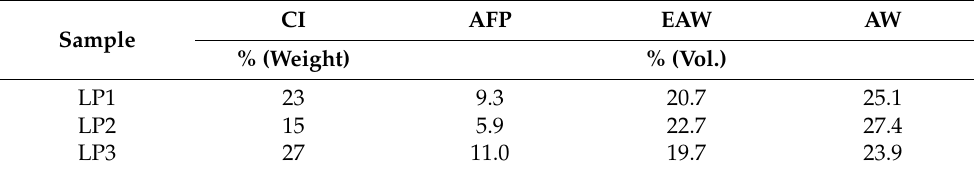
Table 5. Predicted air–water relations for the material collected in La